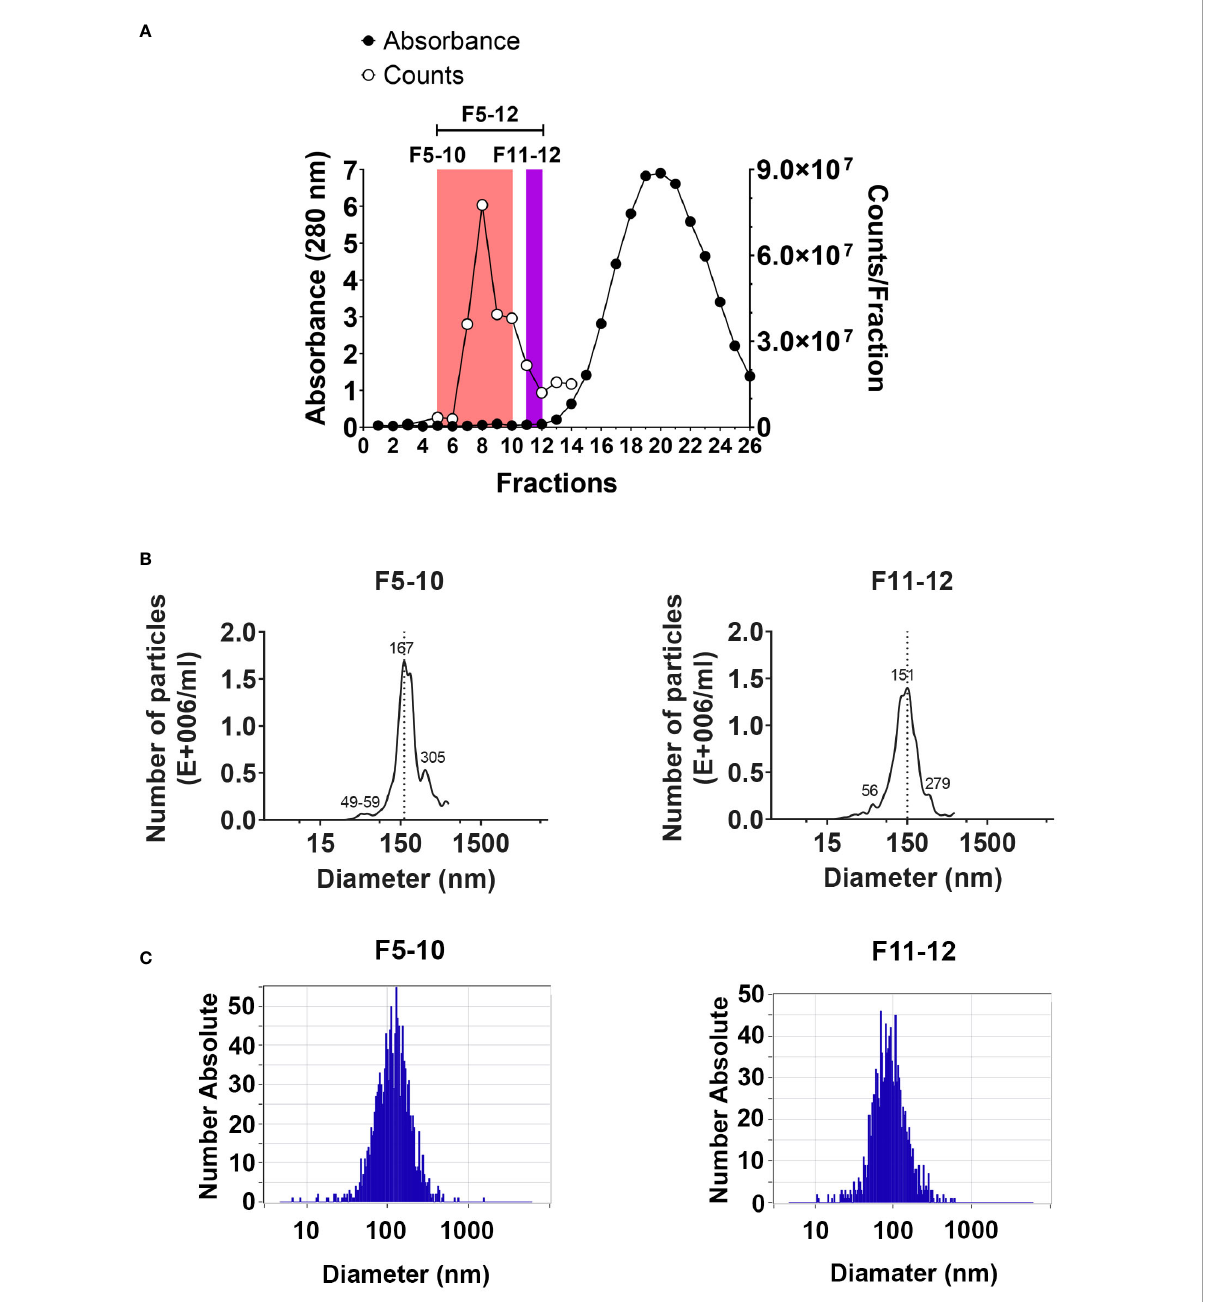
FIGURE 1 EV isolation by size exclusion chromatography. (A) Protein pro fi le detected by absorbance at 280 nm using a Nanodrop spectrophotometer (left Y axis). The number of particles per fraction was assessed by cell fl ow cytometry using the ZE5 cell analyzer (right Y axis). (B) Size distribution of particles in pooled F5-10 and F11-12 fractions from qEV columns using the NanoSight LM10. (C) The same as (B) using the ZetaView